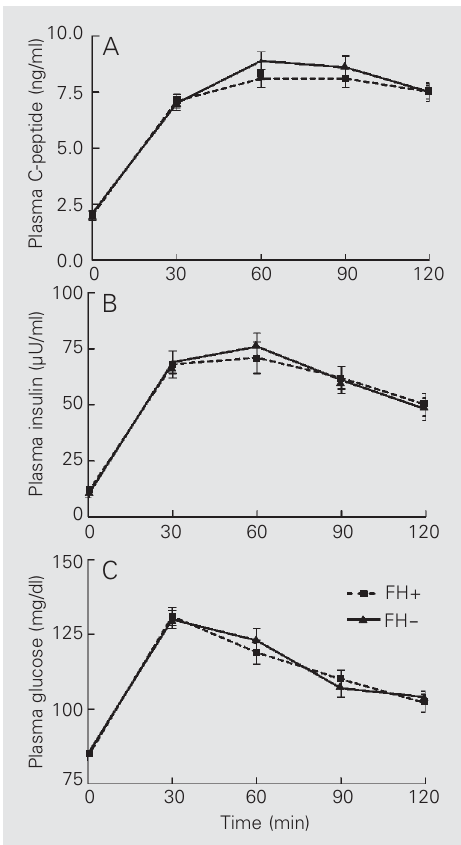
Figure 1. Plasma C-peptide (A), plasma insulin (B), and plasma glucose (C) responses during oral glucose tolerance tests of individuals with (FH+) and with- out (FH-) type 2 diabetic first- degree relatives. Data are re- ported as means ± SEM for 56 individuals in each